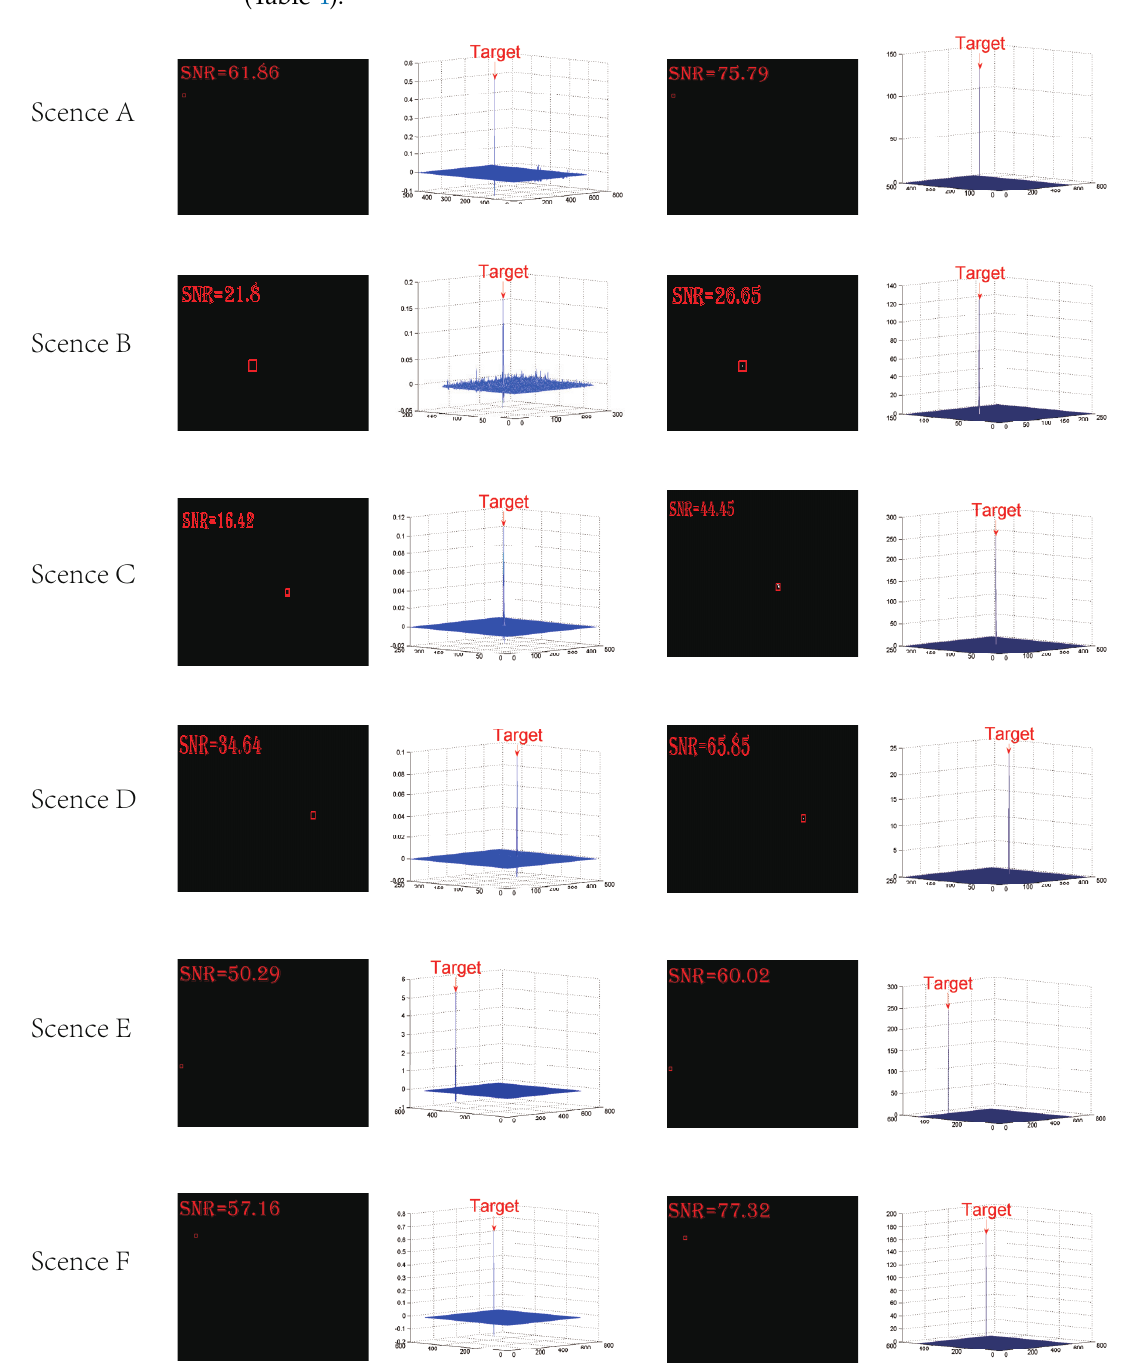
Figure 11. Comparison diagram of energy-enhancement model of local multi-scale gradient maxi- mum before and after energy enhancement for 6